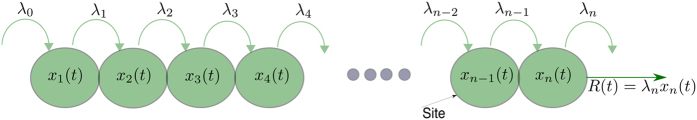
The RFM models unidirectional flow along a chain of n sites.The state variable  represents the density at site i at time t. The parameter λi > 0 controls the transition rate from site i to site i + 1, with λ0 > 0 [λn > 0] controlling the initiation [exit] rate. The output rate at time t is R(t) = λnxn(t).